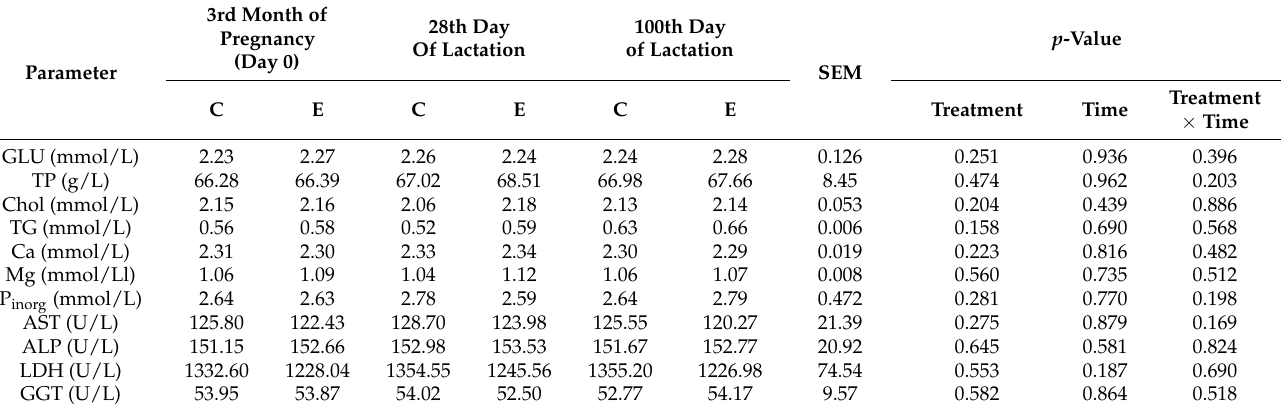
Table 4. Biochemical